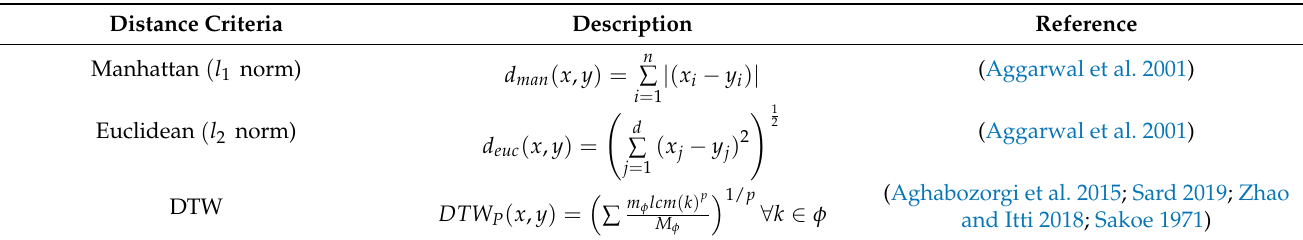
Table 1. Distance